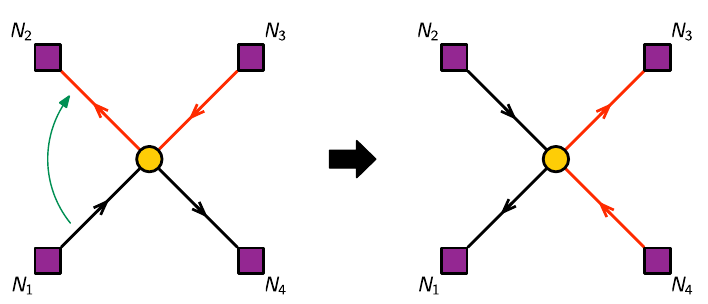
Figure 5 . The transformation of (cid:13)avors under quadrality is a rotation of the corresponding arrows by (cid:25)= 2, while keeping the (cid:13)avor nodes (cid:12)xed. Inverse quadrality is obtained by moving C C or C , or by applying quadrality three 3 4